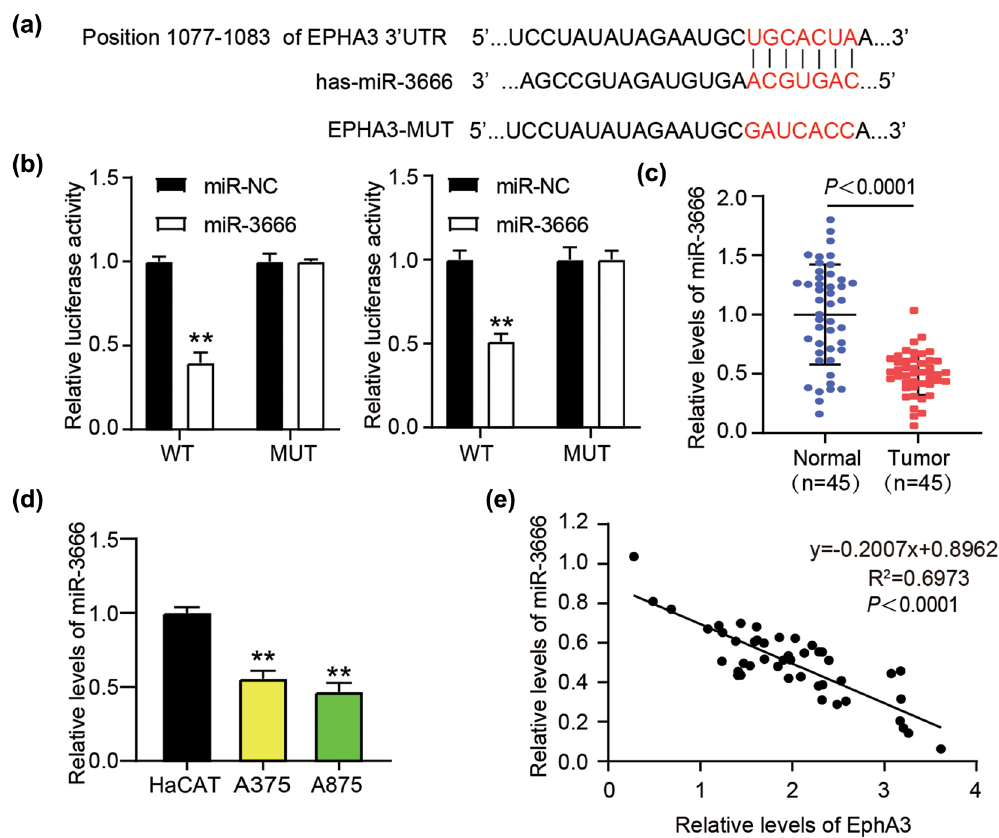
Figure 4: EphA3 is targeted by miR - 3666. ( a ) The base pairing between EphA3 3 ′ UTR and miR - 3666 was predicted by starBase analysis. ( b ) Luciferase activity of EphA3 3 ′ UTR - WT or EphA3 3 ′ UTR - MUT driven was assessed by luciferase system in A375 and A875 cells ’ co - transfection with miR - 3666 mimic or mimic NC. ** P < 0.01 vs miR - NC. ( c ) RT - qPCR analysis of miR - 3666 expression in melanoma tissues and normal tissues. ( d ) RT - qPCR analysis of miR - 3666 expression in melanoma cells ( A375 and A875 ) and HaCAT cells. ** P < 0.01 vs HaCAT. ( e ) Pearson analysis of the correlation between EphA3 and miR -